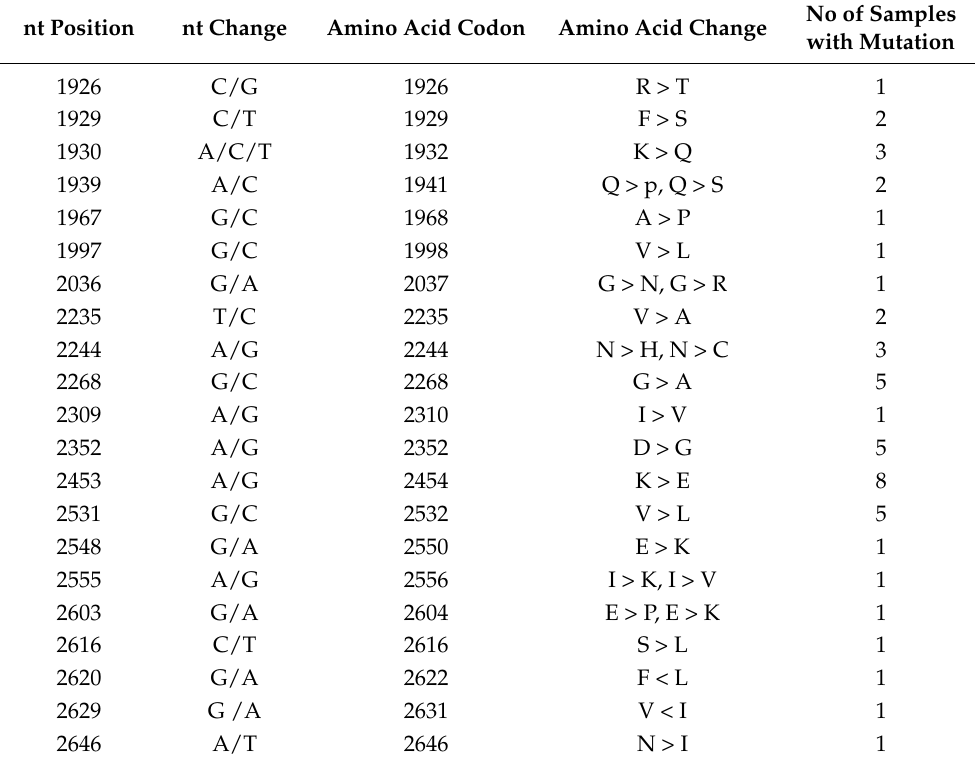
Table 6. Comparisons between different B19V samples at the DNA and protein